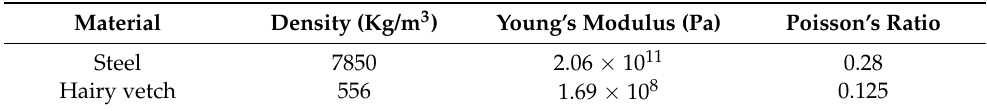
Table 2. Mechanical parameters and mutual contact factors of